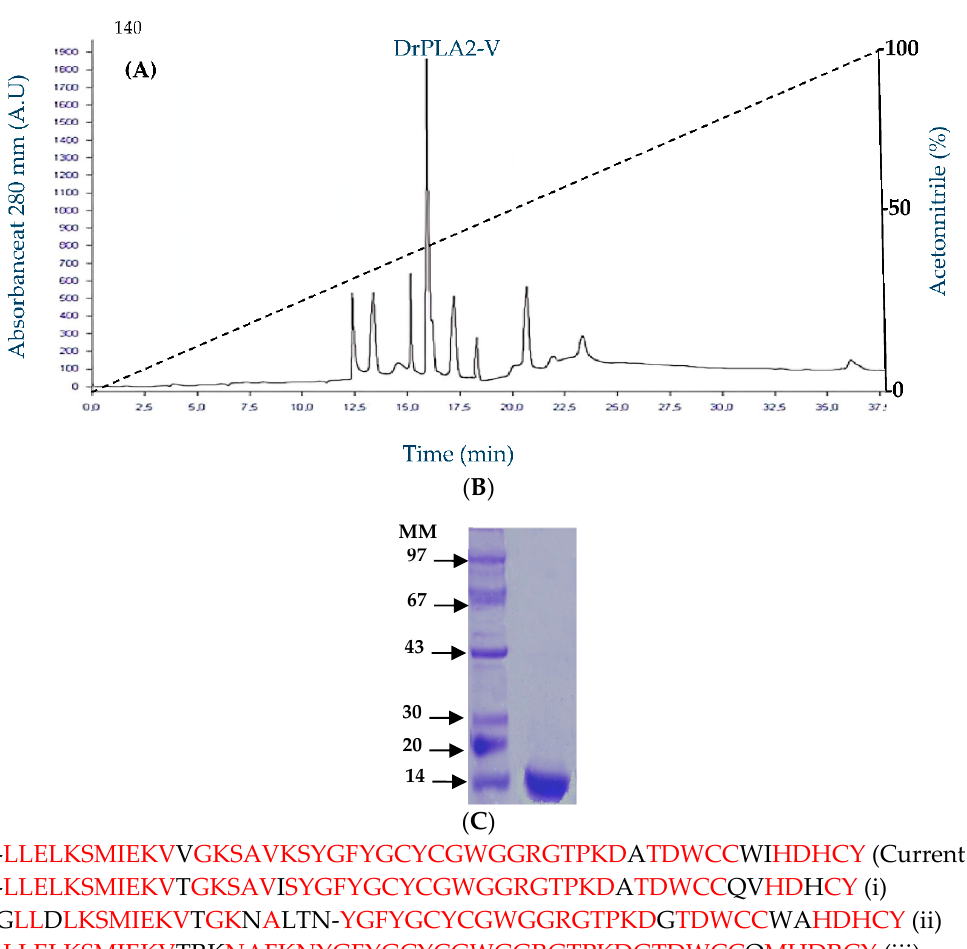
Figure 1. ( A ). Chromatography on RP-HPLC column of the purified DrPLA 2 -V from dromedary